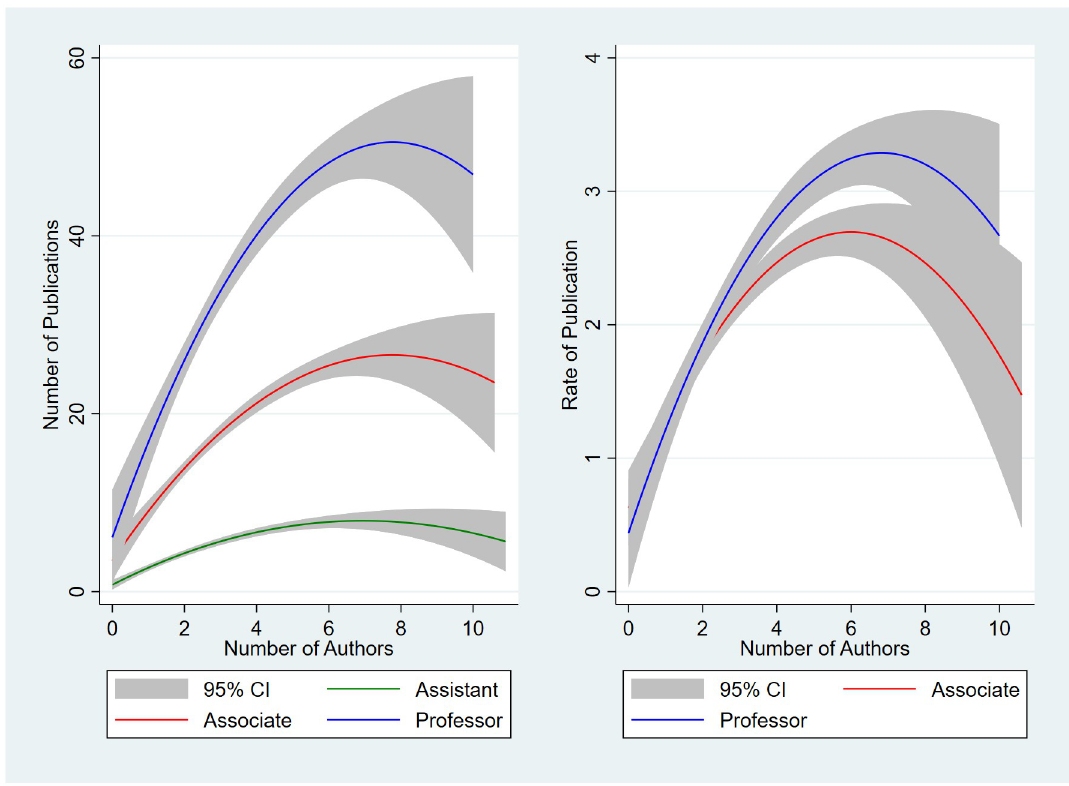
Fig 2. Number and rate of publication vs. number of authors. (A) Number of publications shown on left and (B) rate of publication on right. Assistant professors (Assistant) shown with green lines, associate professors (Associate) with red lines, full professors (Professor) with blue lines, and shaded area is the 95% confidence intervals. Rate of publication not shown for assistant professors as many were hired the same year their PhD was granted forcing division by zero to calculate of the rate of publication.